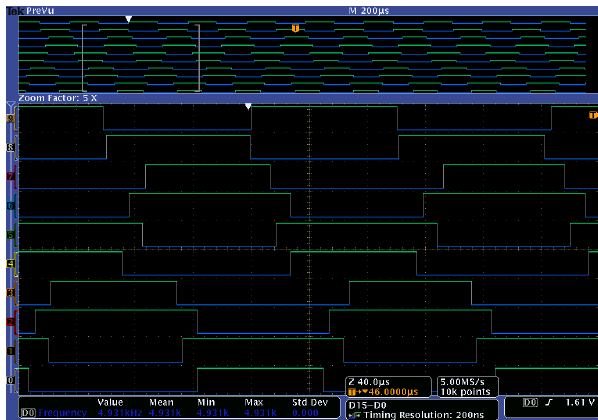
Figure 21. Gate pulses for the ML-DAB IGBTs (from top to bottom: (cid:1845) , (cid:1845) and (cid:1845) , (cid:1845) , (cid:1845) , (cid:1845) and (cid:1845) , (cid:1845) , (cid:1845) , (cid:1845) ) . (cid:2869),(cid:2872) (cid:2870),(cid:2871) (cid:3028)(cid:2869) (cid:3028)(cid:2870) (cid:3028)(cid:2871) (cid:3028)(cid:2872) (cid:3029)(cid:2869) (cid:3029)(cid:2870) (cid:3029)(cid:2871) (cid:3029)(cid:2872) Table 3. Experimental efficiency and losses for the prototype ML-DAB.